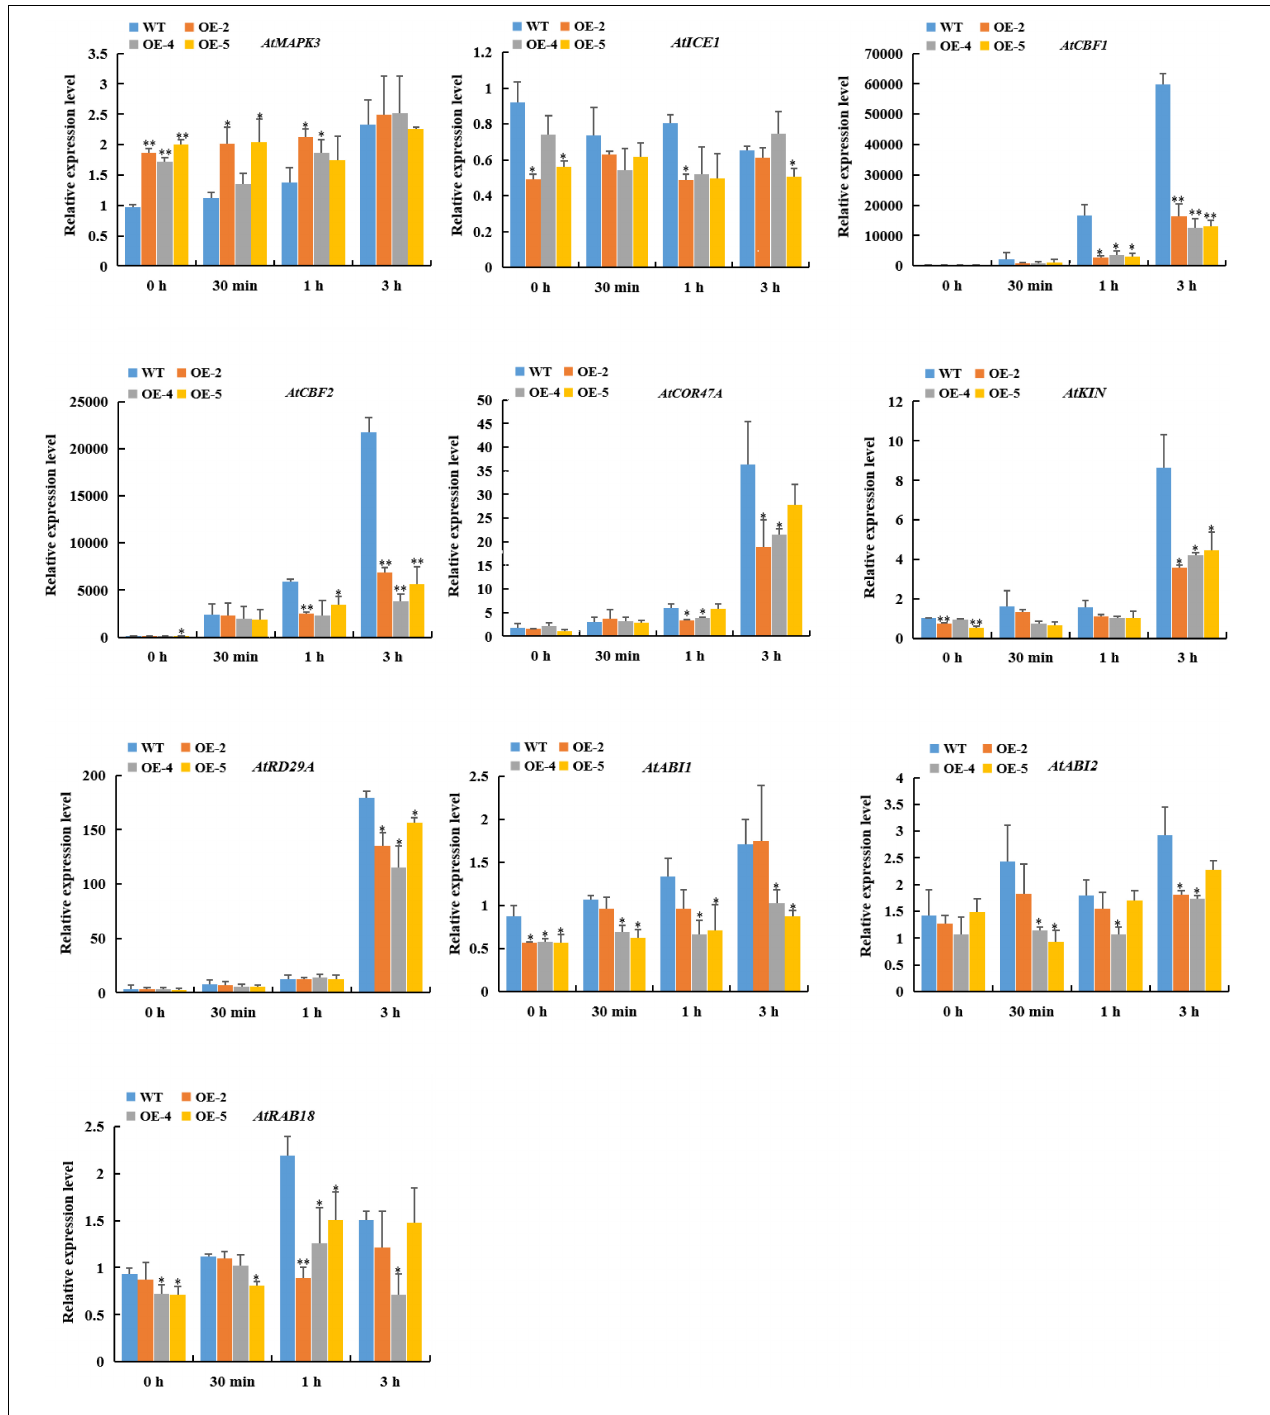
FIGURE 9 | Expression pattern of cold-induced marker genes in WT and transgenic lines subjected to cold stress (4 ◦ C) for the indicated times. Data represent the mean ± SD of three independent biological replicates. Asterisks indicate a significant difference between wild type and overexpressed lines ( ∗ P < 0.05, ∗∗ P < 0.01, student’s t -test). WT, wild